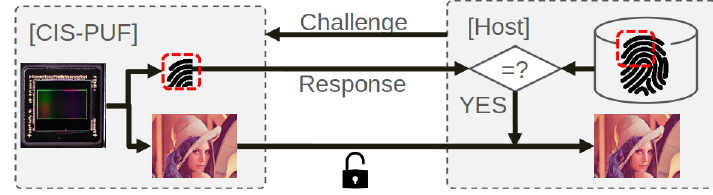
Figure 1. Verification phase of challenge–response